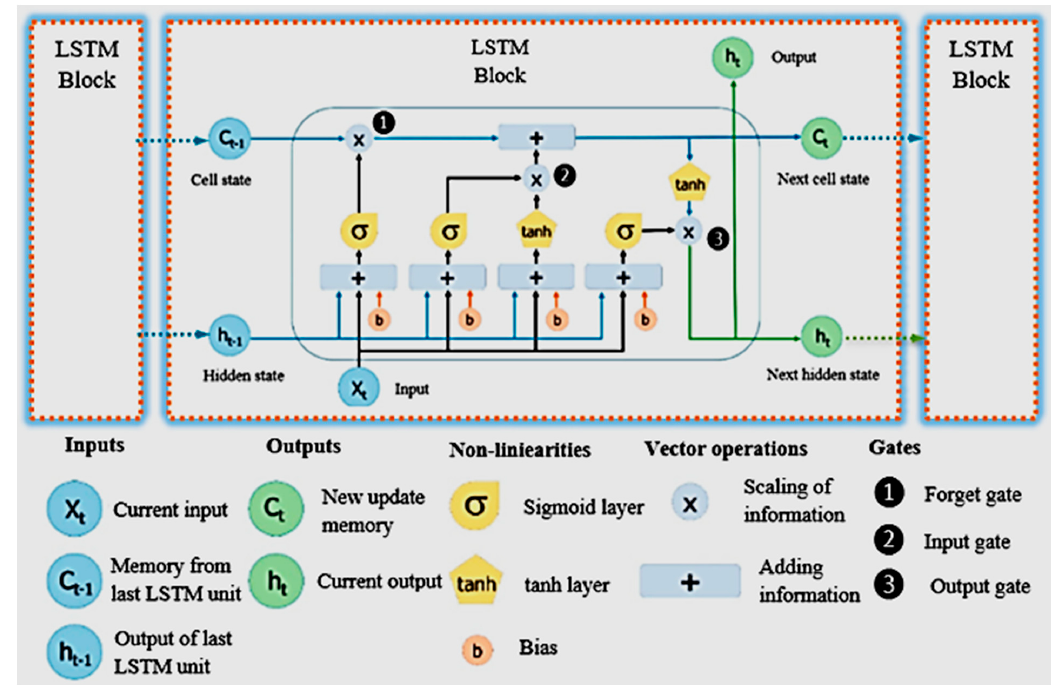
Figure 1. The structure of long short-term memory (LSTM) neural networks (NN) blocks with their corresponding symbols and meanings.